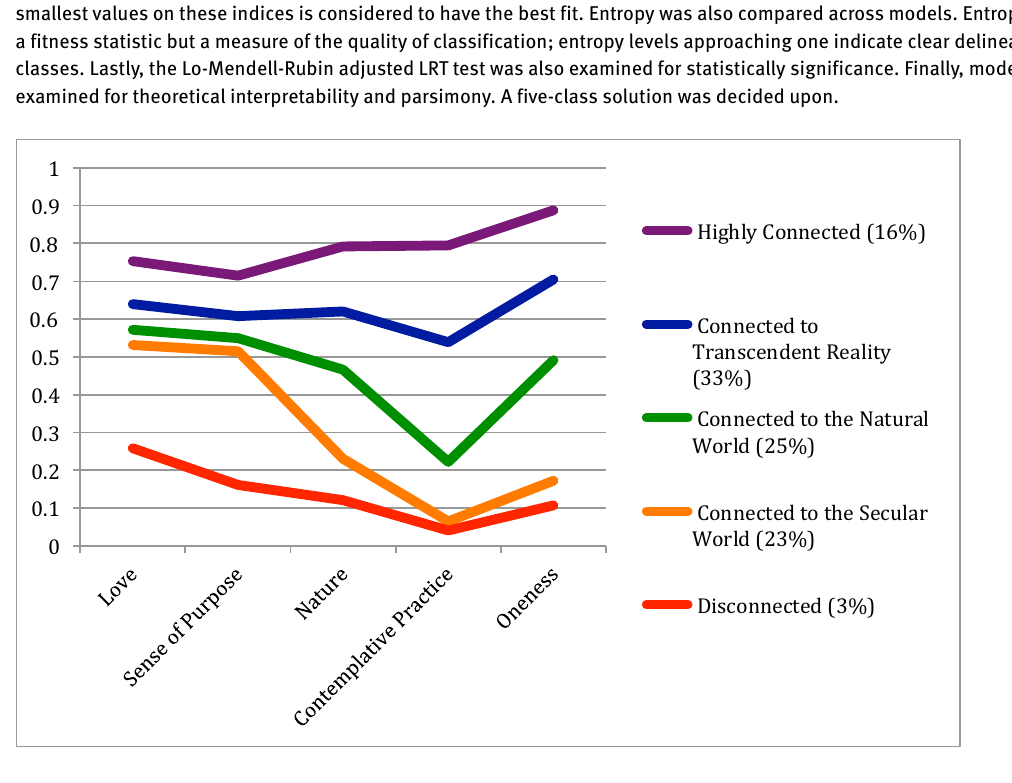
Figure 2. Five Class Unconditional Model of Connection in Adults in the United States by Latent Class Analysis